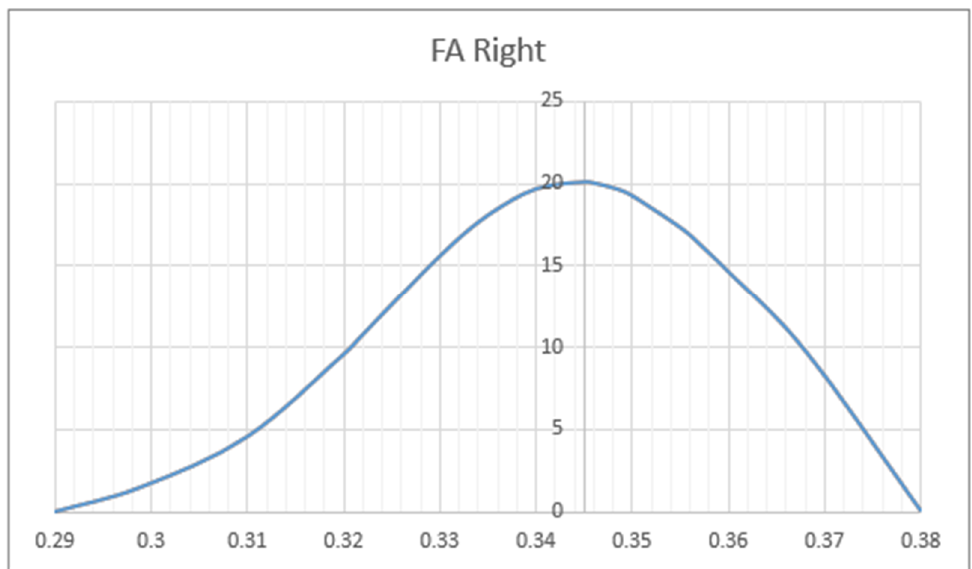
Figure 8. Distribution charts of FA in the right hemisphere of the group of 34 patients aged 25–82.